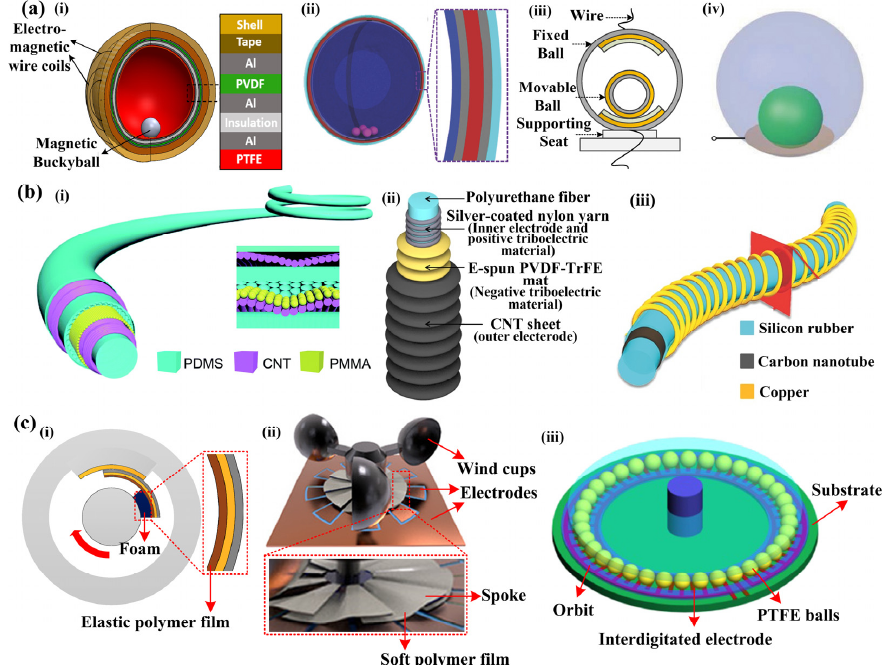
Figure 7. Structures of ( a ) ( i – iv ) sphere-based sensors, (( i ) Reproduced with permission [26]. Copyright 2018 Elsevier; ( ii ) Reproduced with permission [59]. Copyright 2017 WILEY-VCH Verlag GmbH &